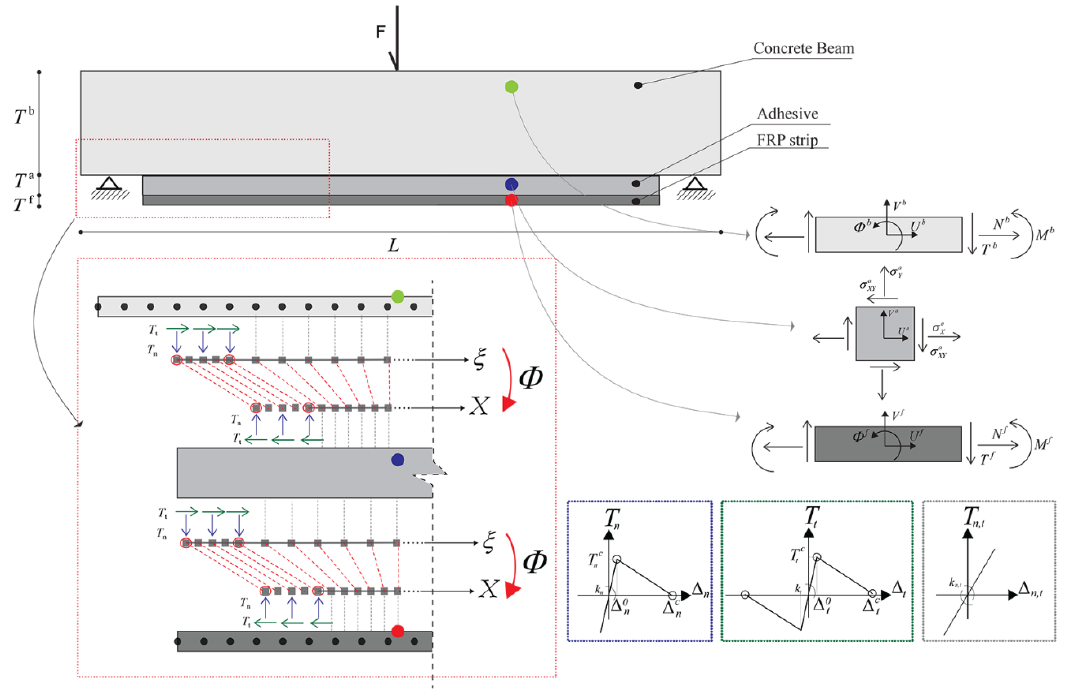
Figure 1. General representation of the numerical model.